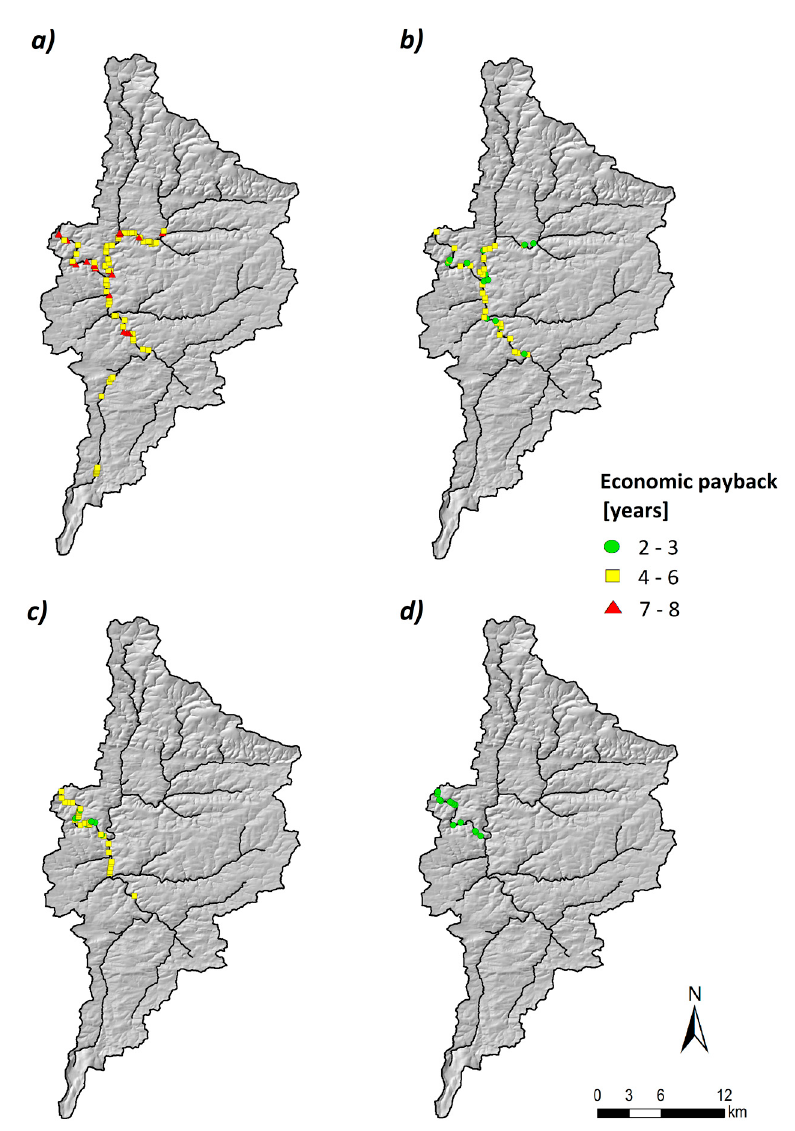
Figure 11. Maps of run-of river potential sites for 50% dependability and the related economic payback for turbine and generator (years): ( a ) 20 kW ≤ P ≤ 50 kW; ( b ) 50 kW < P ≤ 100 kW; ( c ) 100 kW < P ≤ 200 kW; and, ( d ) P > 200 kW.